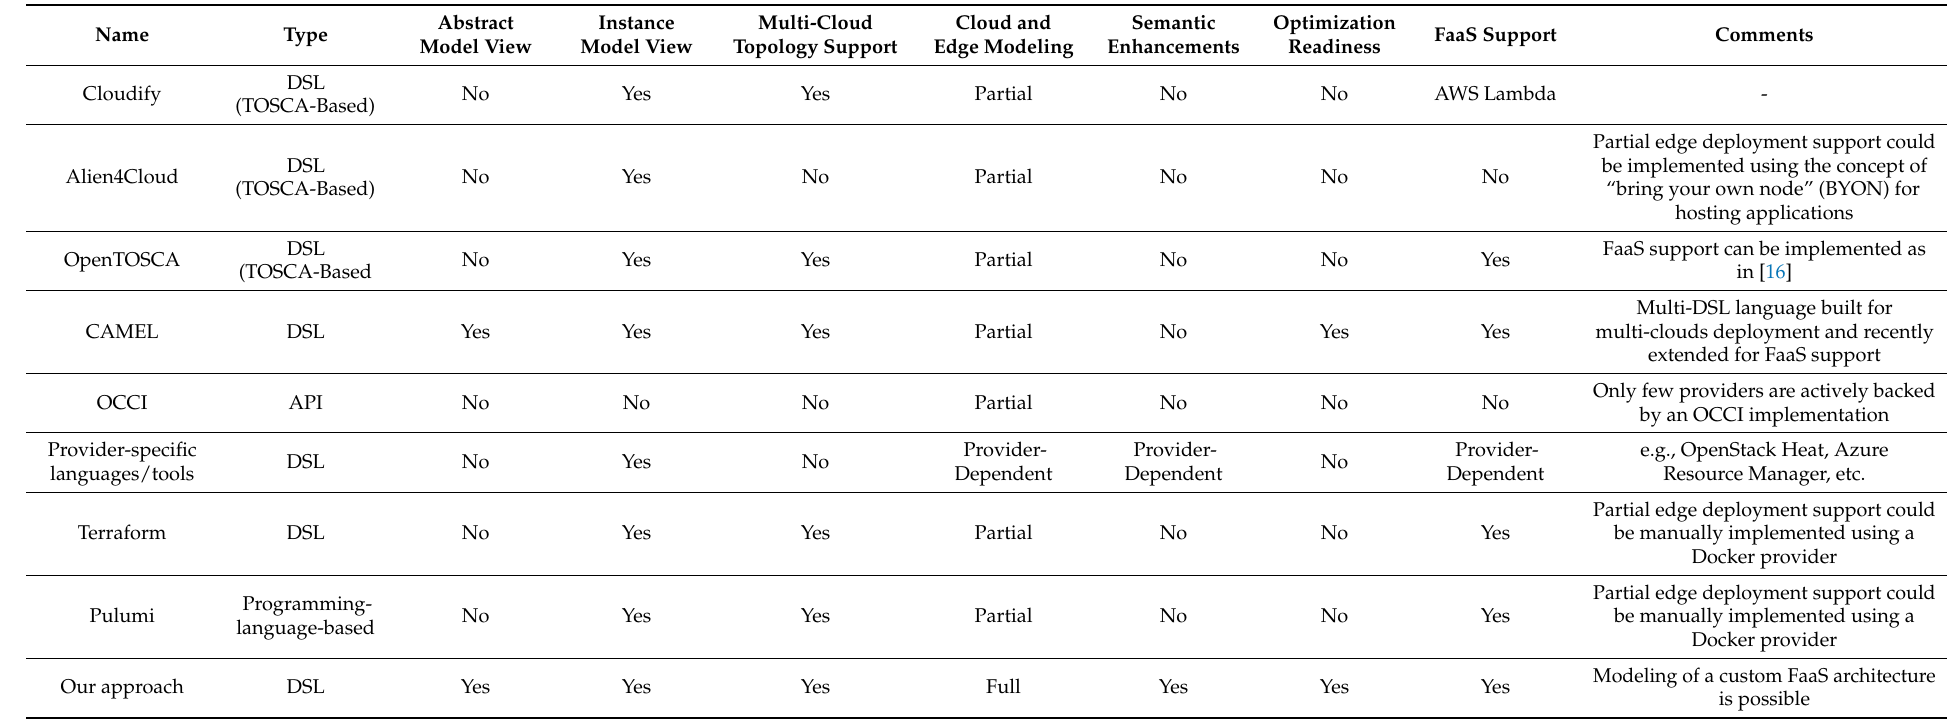
Table 6. Notable cloud application deployment